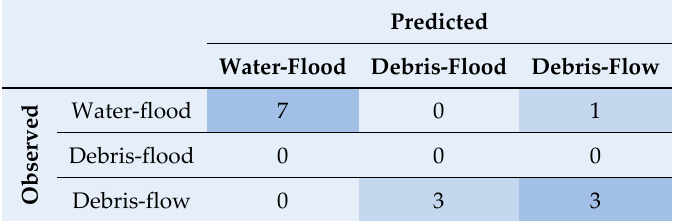
Table 5. Confusion matrix of the validation against the documentary dataset.